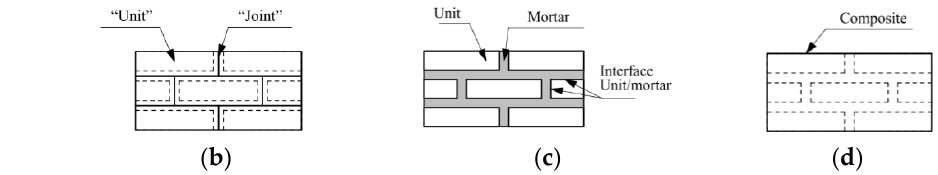
Figure 13. Different modelling strategies for a ( a ) Masonry sample. ( b ) Micro-modelling, ( c ) Simpli- fied micro-modelling, and ( d ) Semi macro-micro-modelling [300].